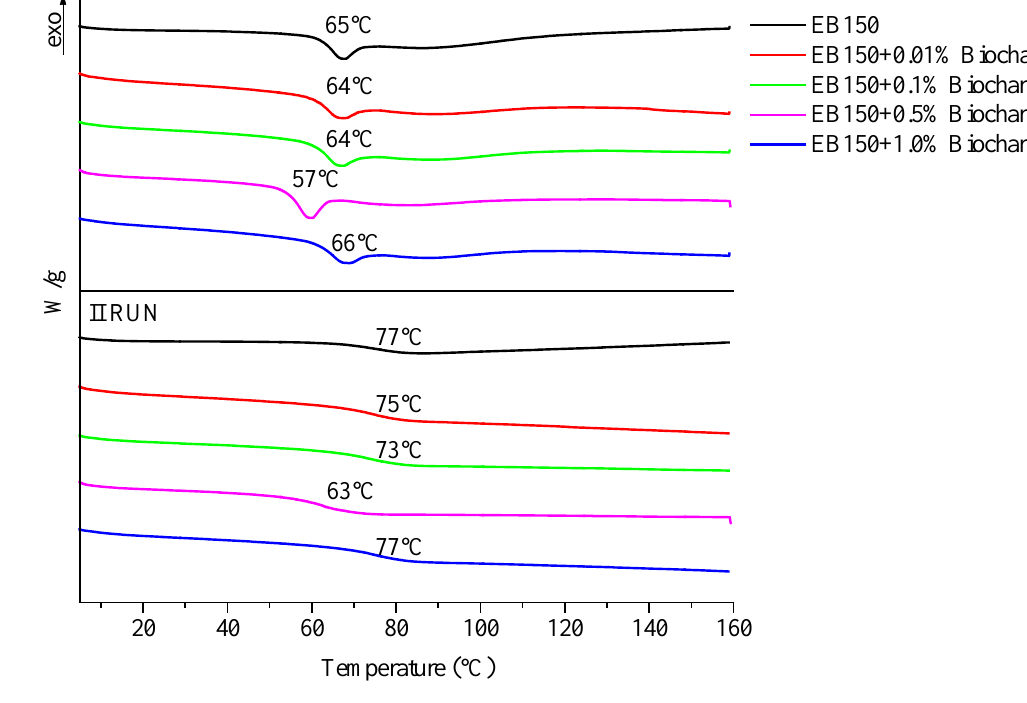
Figure 7. Differential scanning calorimetry (DSC) traces (1st and 2nd heating up) for UV-LED cured EB150 and its composites with different biochar loadings.